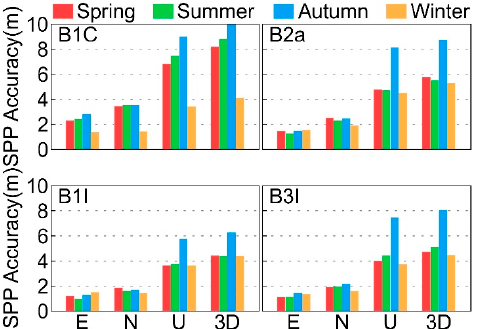
Figure 8. The average SPP accuracies with the BDGIM on the days of spring equinox (red), summer solstice (green), autumn equinox (blue) and winter solstice (orange). The four panels represent the signals of B1C ( upper left ), B2a ( upper right ), B1I ( lower left ) and B3I ( lower right ).